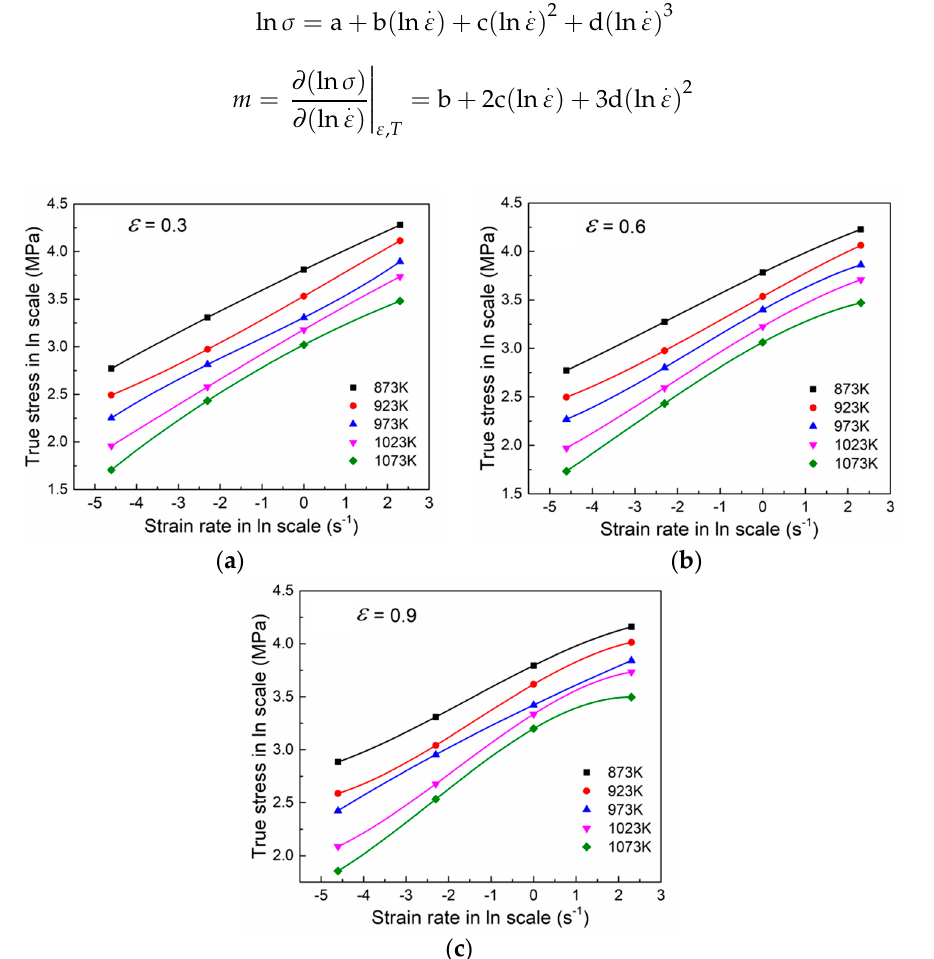
ε ε ε = 0.3, ( b ) = 0.6, ( c )